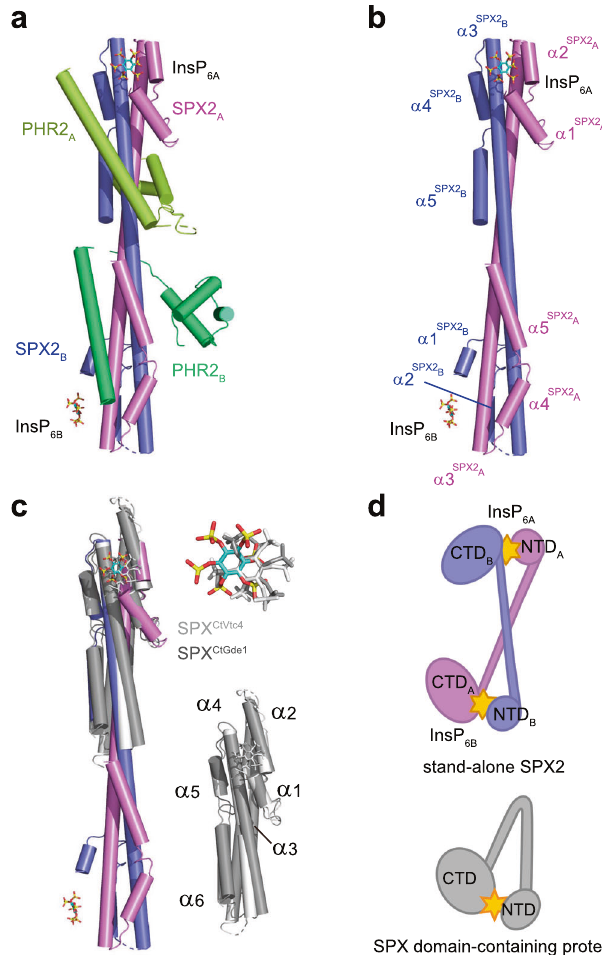
Fig. 1 The structure of rice SPX2/InsP 6 /PHR2 complex and topology differences between the rice stand-alone SPX2 and SPX domain- containing proteins. a Overall structure of the ternary complex. The protomers of the two SPX2 and the two PHR2 molecules are colored in magenta, blue, yellow, and green cartoon representation, respectively. InsP 6 molecules are represented in sticks. b Domain-swapped conformation of the SPX2 dimer in the SPX2/InsP 6 /PHR2 complex. The α -helices of each protomer are numbered and highlighted in magenta and blue, respectively. PHR2 has been omitted for clearity. c Structural comparison between the stand-alone SPX2 dimer and other monomeric SPX domain-containing proteins. SPX domain-containing proteins are colored in gray with numbered secondary structures. PHR2 has been omitted for clearity. d Topological diagrams of the stand-alone SPX2 other SPX domain-containing protein. InsP 6 is represented in yellow